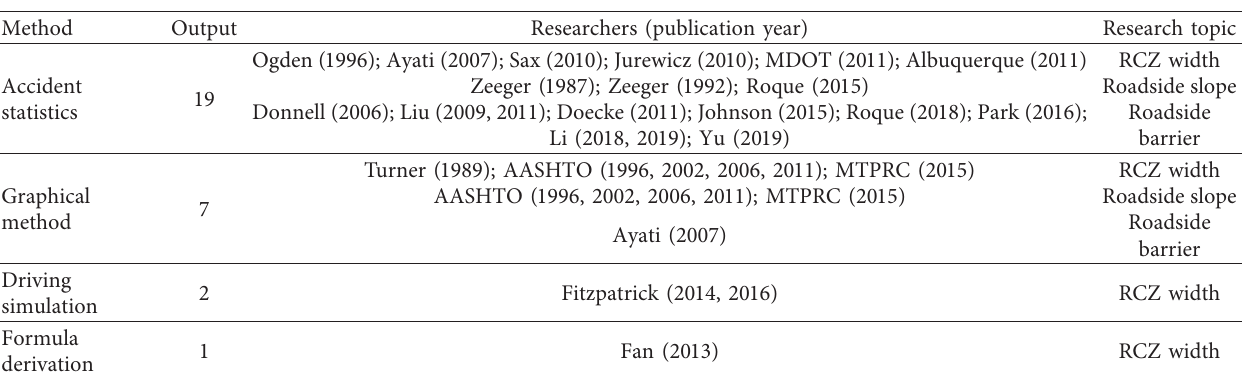
Table 1: Statistical